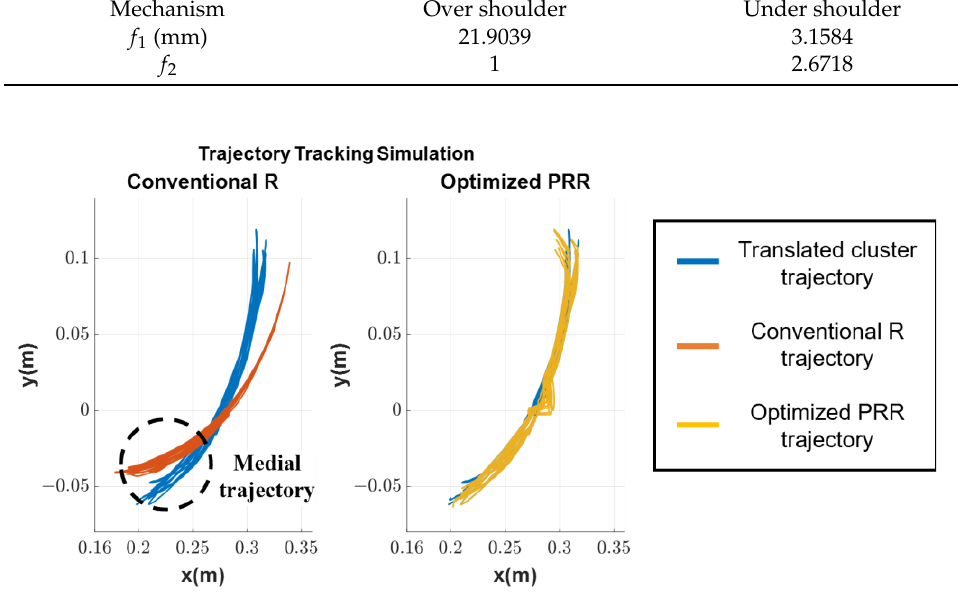
Figure 10. Trajectory tracking simulation of conventional R and optimized PRR configurations. The origin of the simulation plot is the position of the marker attached at the medial point of the back.